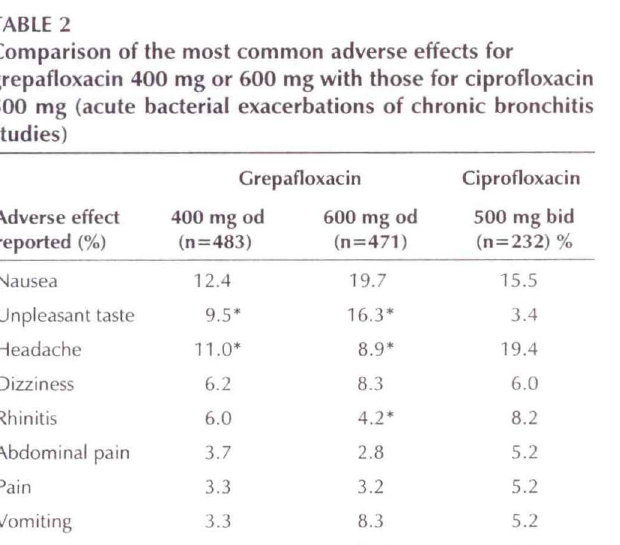
Comparison of the most common adverse effects for grepafloxacin 400 mg or 600 mg with those for